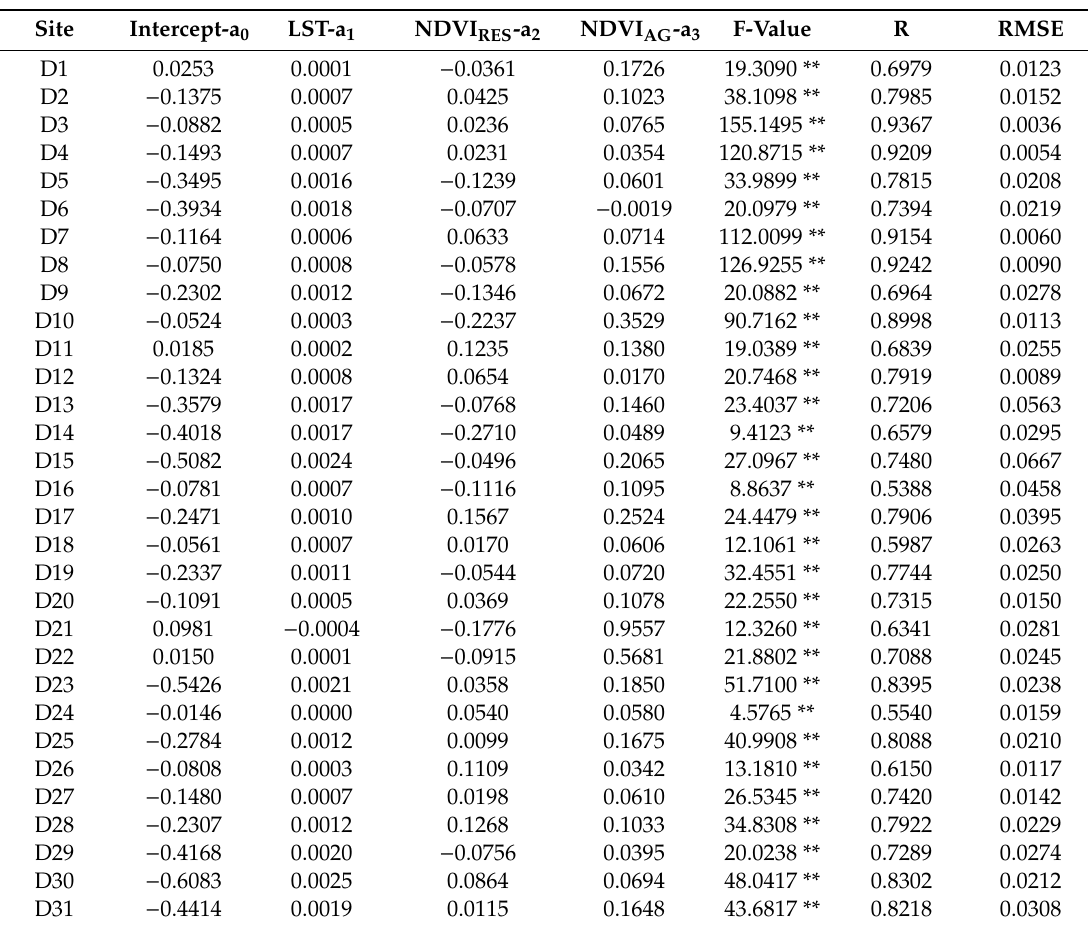
Table A4. The 50–70 cm layer soil moisture estimation